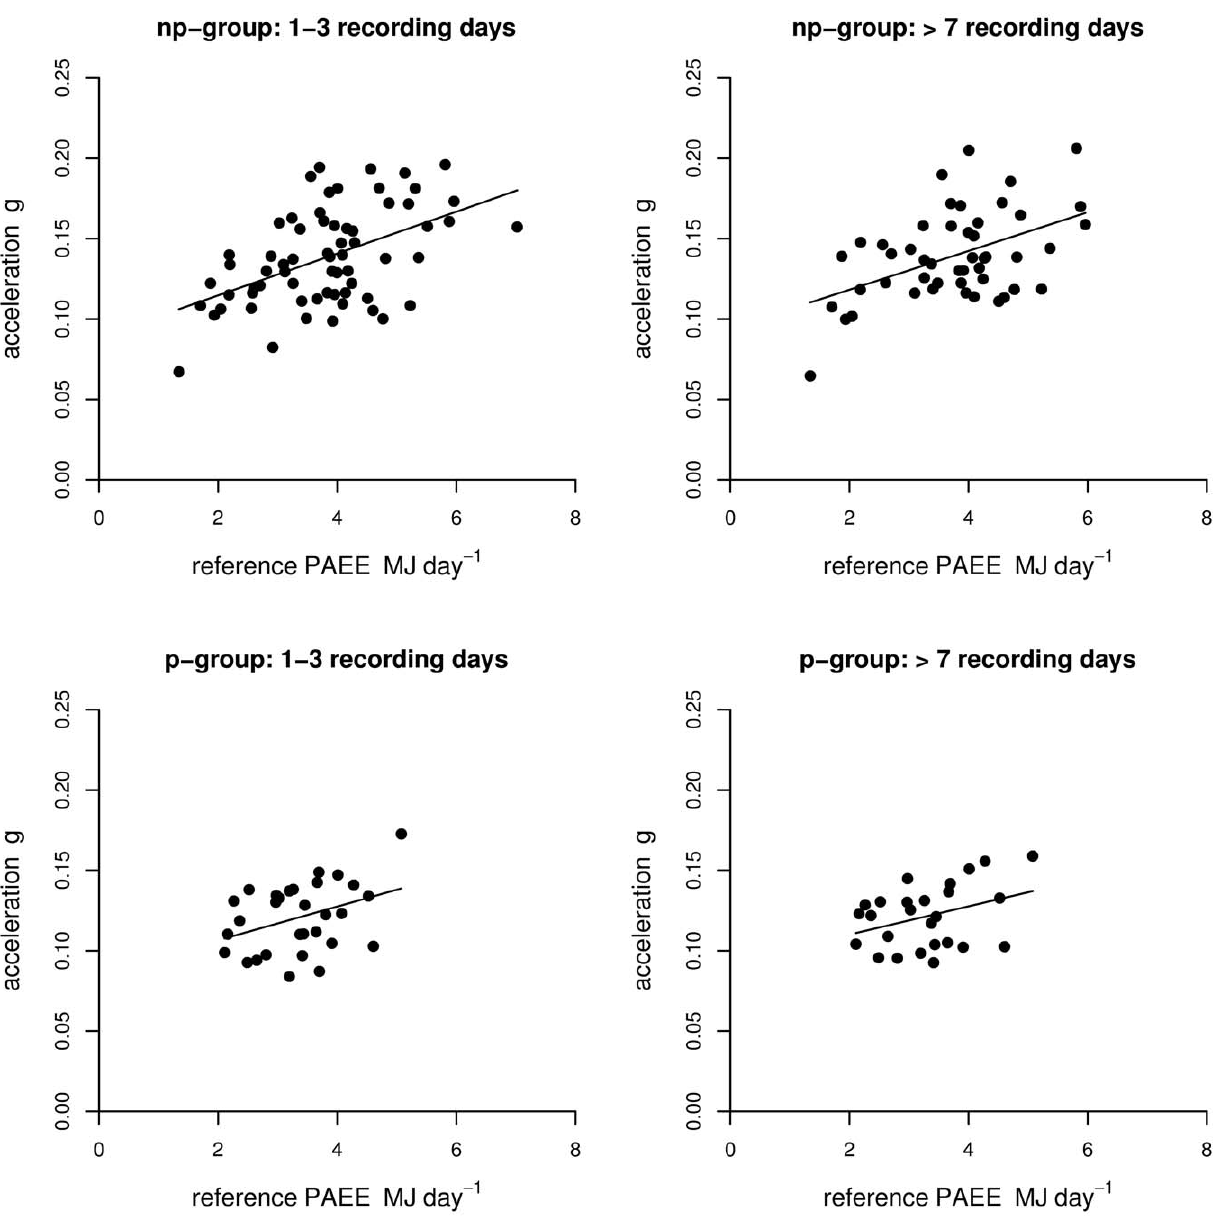
Figure 2. Acceleration (Acc 2 ) as a function of physical activity-related energy expenditure (PAEE) in MJ day 2 1 for p-group (pregnant) and np-group (non-pregnant). Lines represent the best fit of the data. See table 3 (model 1) for regression equation.